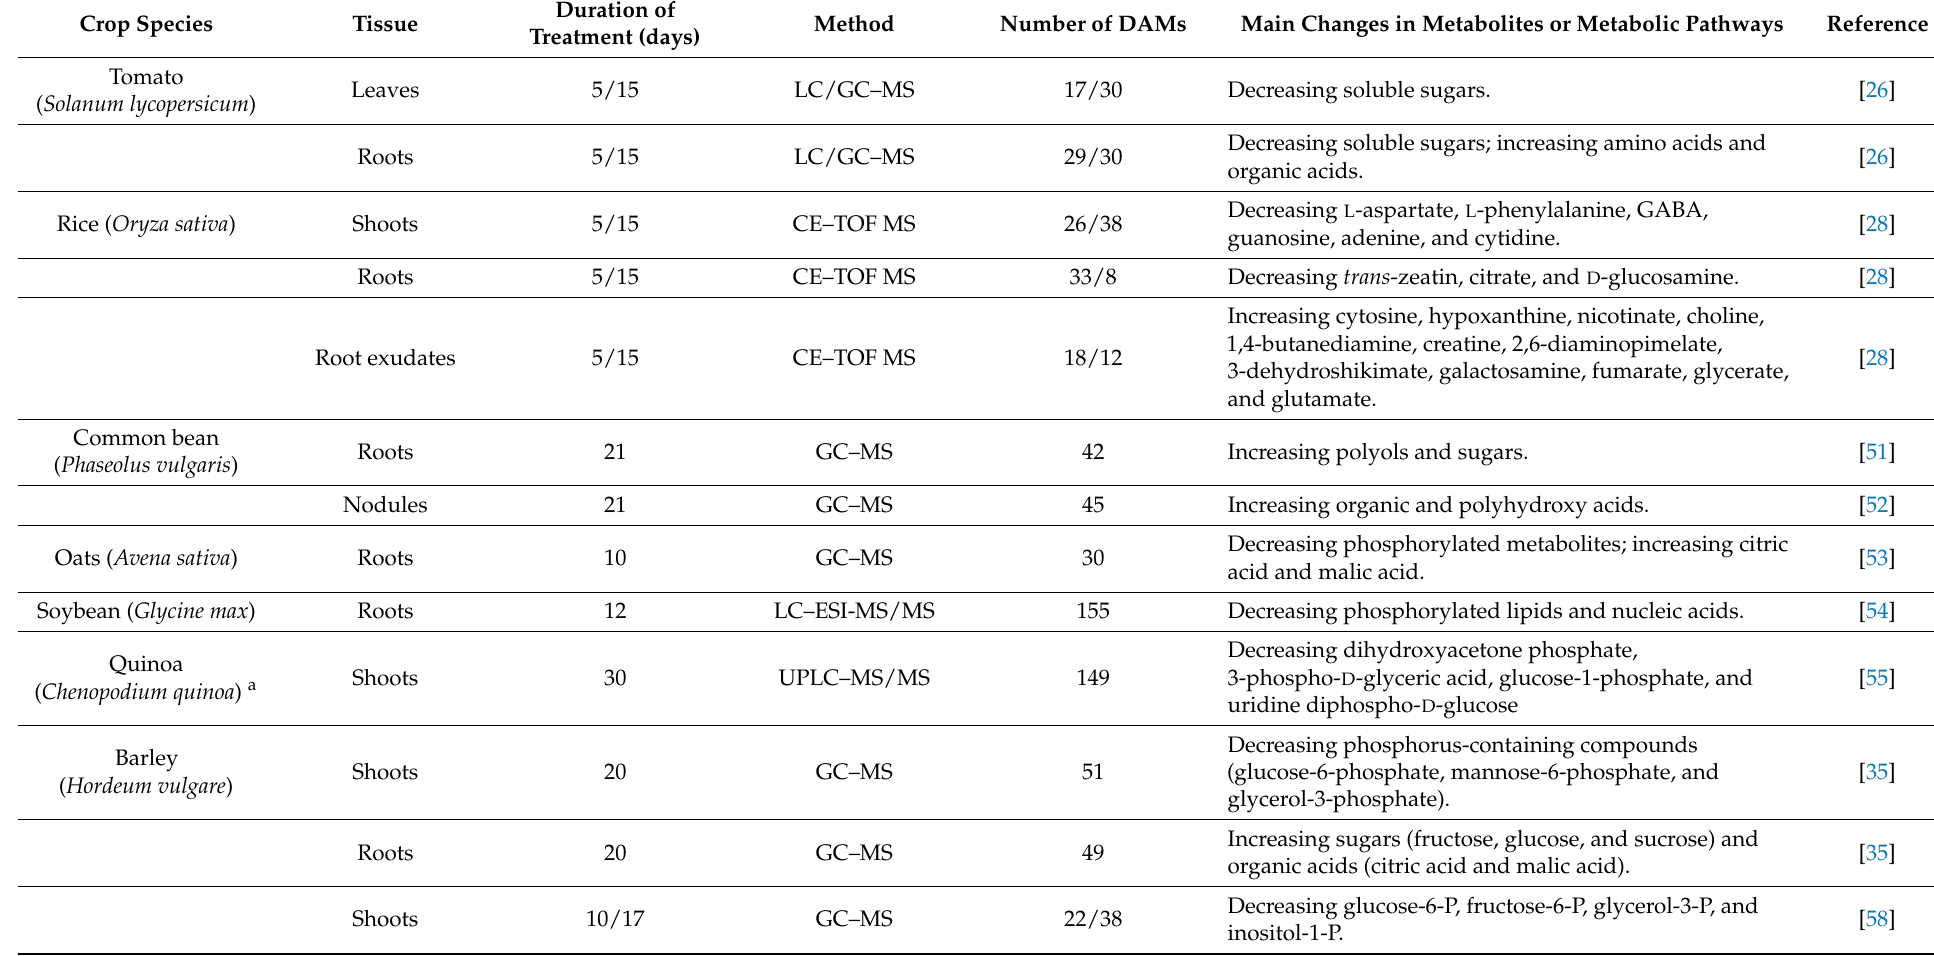
Table 2. Metabolome analyses of crop responses to P